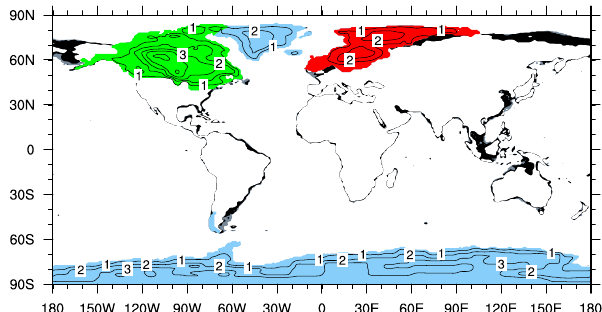
Fig. 1. LGM ice sheet extent (color shadings: red and green for the Fennoscandian and Laurentide ice sheet, respectively,andlightblueforGreenlandandAntarctica)andthickness(contours,interval1km),andadditional landareasinMW(black)andLGM(blackandgray). ThecoastlinesandicesheetsforLGMarebasedonICE- 5G (Peltier, 2004). The shift of the coastlines (shown as the boundary of 50% landfraction) corresponds to a sea-levelchangeof80m(MW)and120m(LGM)withrespecttotoday.